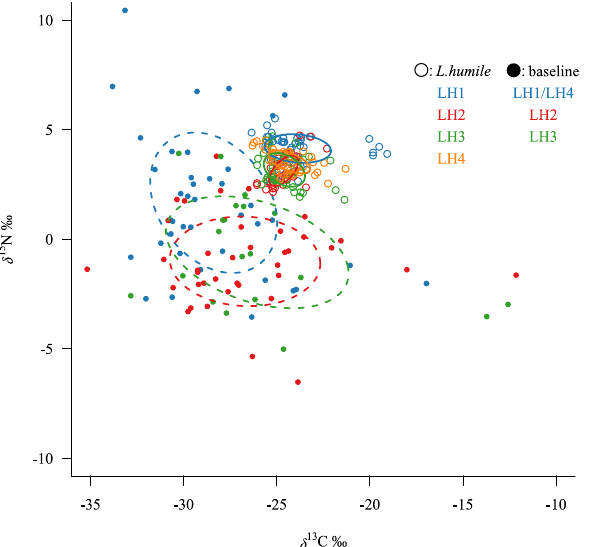
Figure 4. Differences in the standard ellipse areas (SEAs) among the four supercolonies of L. humile ( solid line ellipses and open dots ) established in Kobe, Hyogo, Japan, and among baseline organisms (arthropods) ( dashed line ellipses and filled dots ) collected within the sampling site of each supercolony (LH1/LH4, LH2, and LH3), calculated from the δ 13 C and δ 15 N biplot data using the R package “SIBER” 32 .